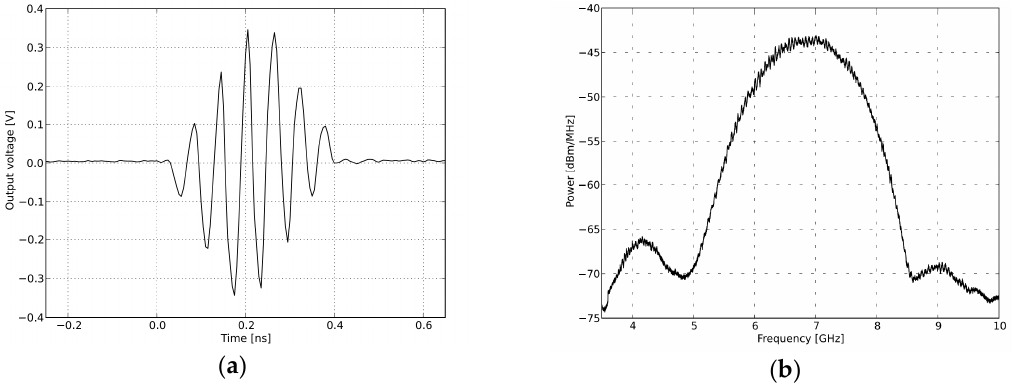
Figure 7. Transmitted signal in the time domain and frequency domain. ( a ) Pulse generator time domain output; ( b ) pulse generator output spectra.